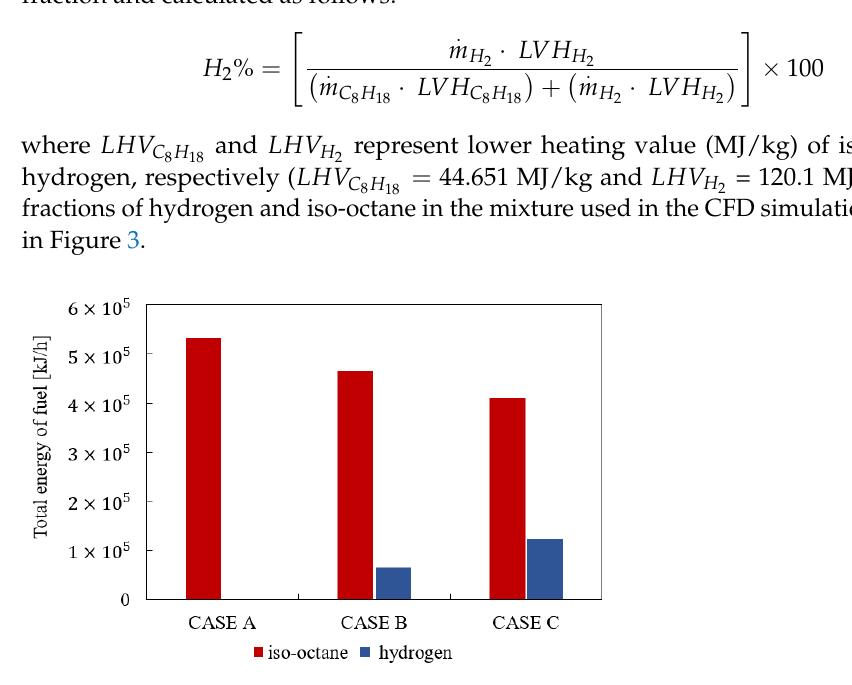
Figure 3. Energy fractions of hydrogen and iso-octane in the mixture.